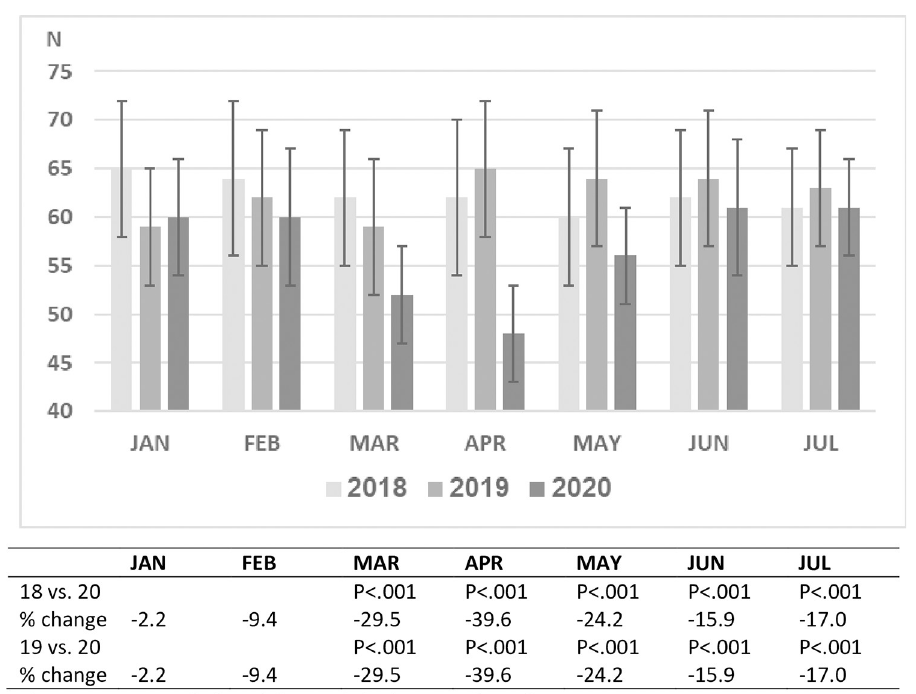
Fig 5. Mean daily adult ED visits by month and year.